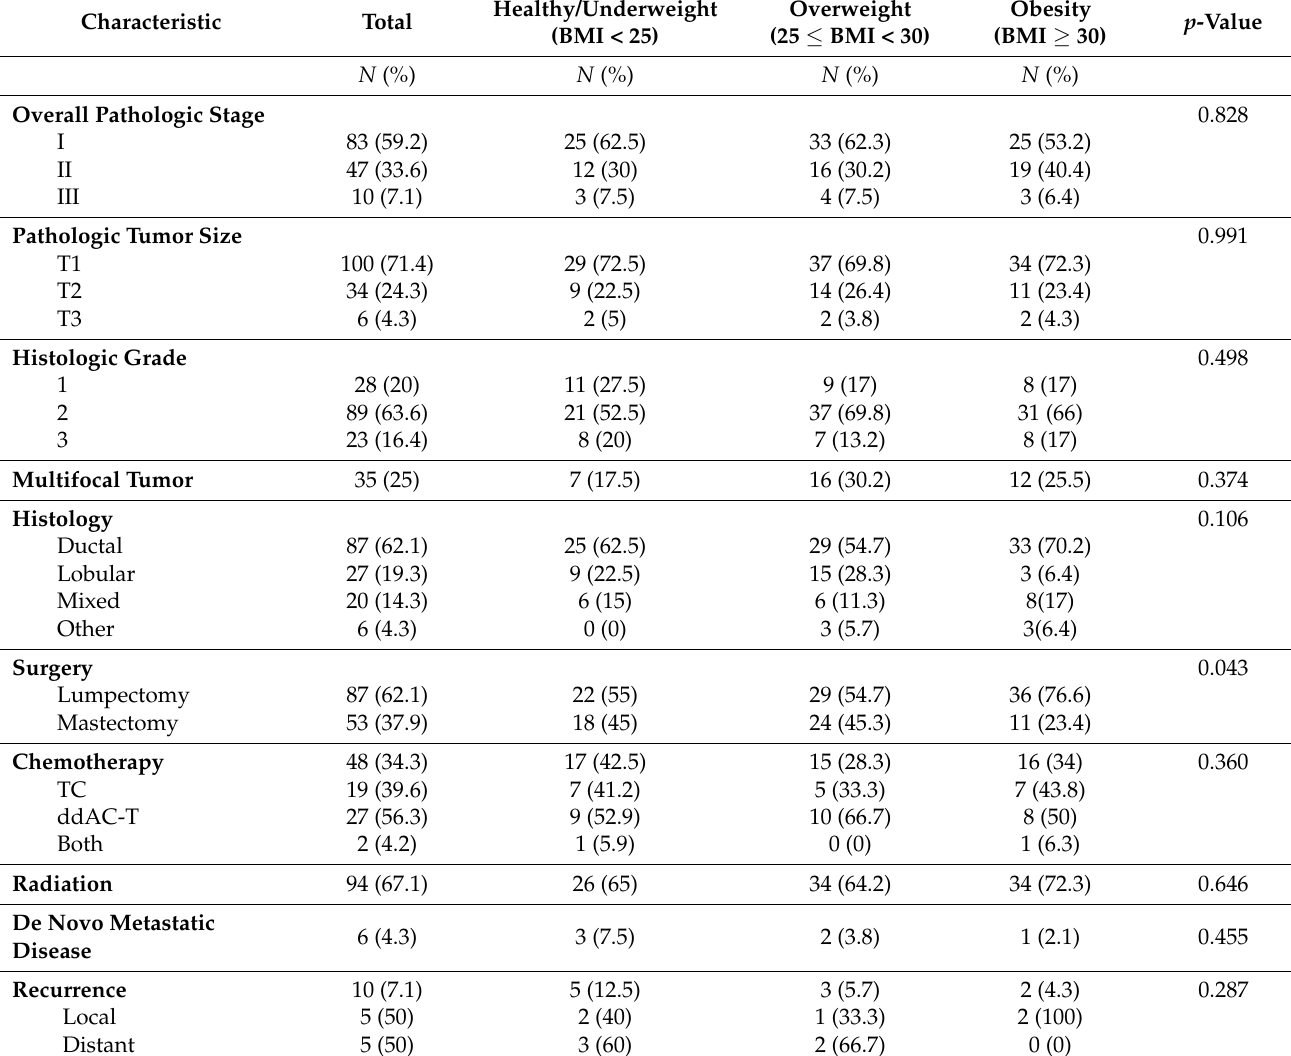
Table 2. Tumor and Treatment Characteristics by BMI Status ( N =